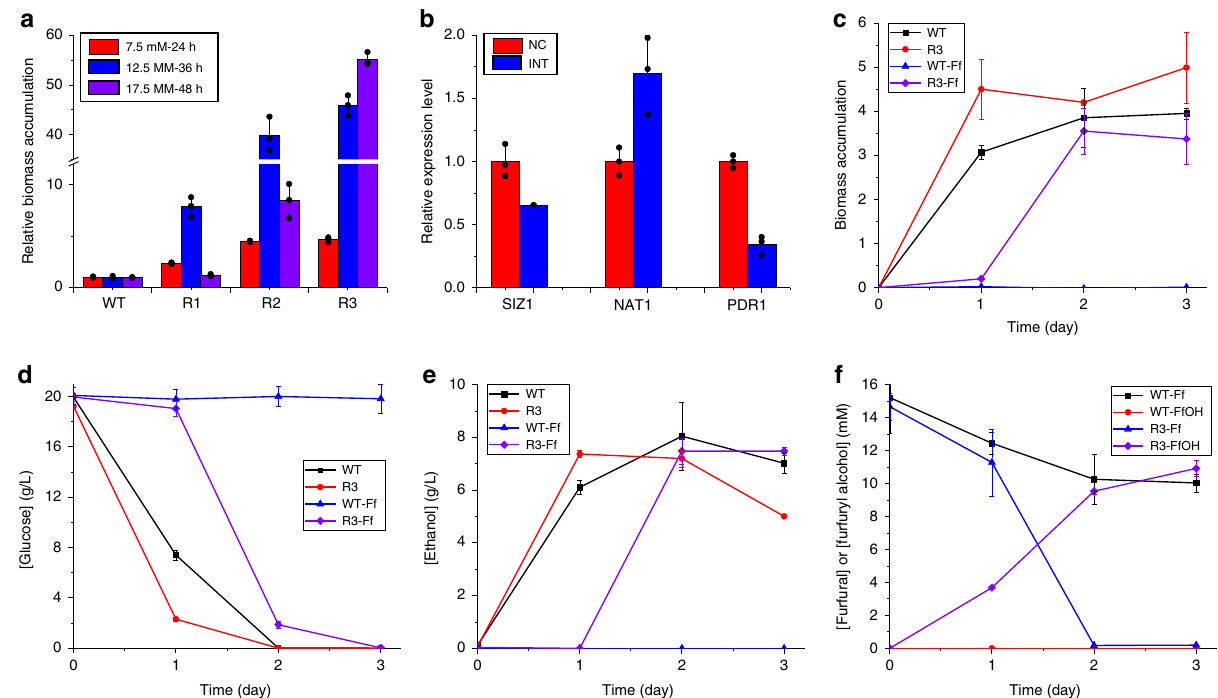
Fig. 3 iMAGIC for the construction of a furfural tolerant yeast strain. a Furfural tolerance of the engineered strains identi fi ed in each round of iMAGIC screening, R1, R2, and R3. The cell densities of the engineered strains were normalized to the wild-type (WT) strain under the speci fi ed conditions (red bars for 7.5 mM furfural, blue for 12.5 mM, and purple for 17.5 mM). b Veri fi cation of gain-of-function and reduction-of-function mutations by qPCR. The expression level of each target ( SIZ1 , NAT1 , and PDR1 ) was compared before (NC, red) and after (INT, blue) CRISPRa or CRISPRi cassette integration. Fermentation pro fi les including cell density c , glucose consumption d , ethanol production e , as well as furfural and furfuryl alcohol (FfOH) concentration f of WT (black square and blue triangle) and R3 (red circle and purple diamond) in synthetic medium with (blue triangle and purple diamond) or without (black square and red circle) the supplementation of 17.5 mM furfural (Ff). A single colony of WT or R3 was inoculated into 3 mL SED/G418 medium and cultured until saturation, which was then transferred into 50 mL fresh SED/G418 medium with or without the supplementation of 17.5 mM furfural in a 250 mL un-baf fl ed shaker fl ask. Fermentation was performed under oxygen-limited conditions (30 °C and 100 rpm), and samples were taken every 24 h. The decrease of furfural concentration in WT might result from evaporation, as no growth and furfuryl alcohol production were observed. Notably, the cell density (biomass accumulation) in f was determined by measuring the absorbance at 600 nm using a UV – vis spectrometer. Error bars represent the mean ± s.d. of biological triplicates. The source data are provided as a Source Data fi